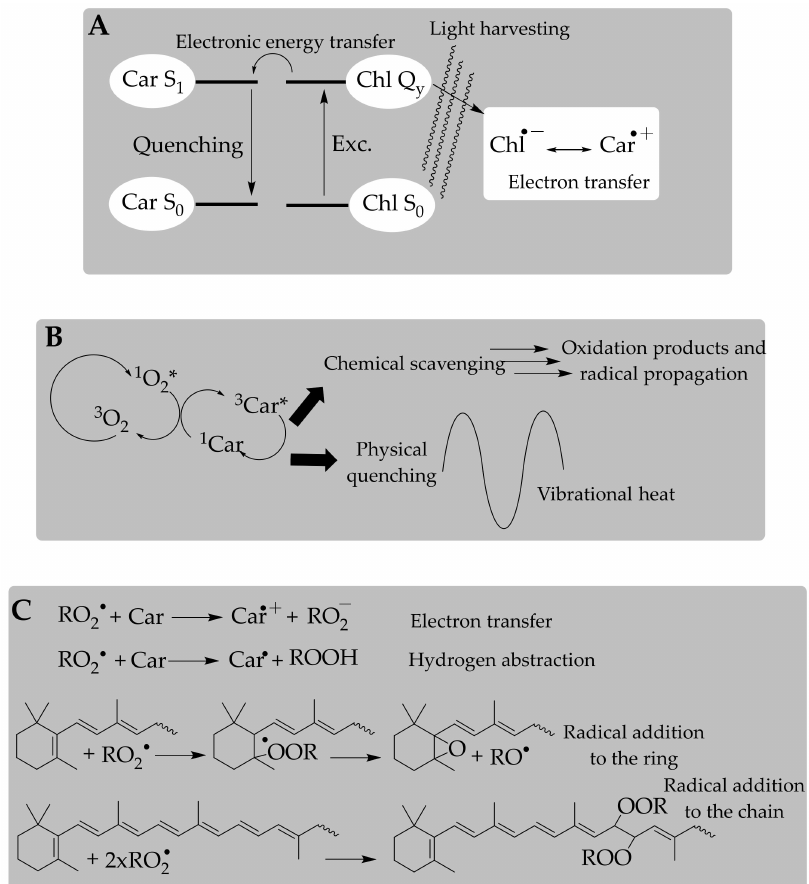
Figure 2. Mechanisms of the antioxidant action exerted by carotenoid pigments in di ff erent processes. The electron transfer from the characteristic conjugated polyenic chain of carotenoids to chlorophylls ( A ). Physical quenching of singlet oxygen ( B ). Electron transfer, hydrogen abstraction, and radical addition in the antioxidant activity against peroxyl radicals ( C